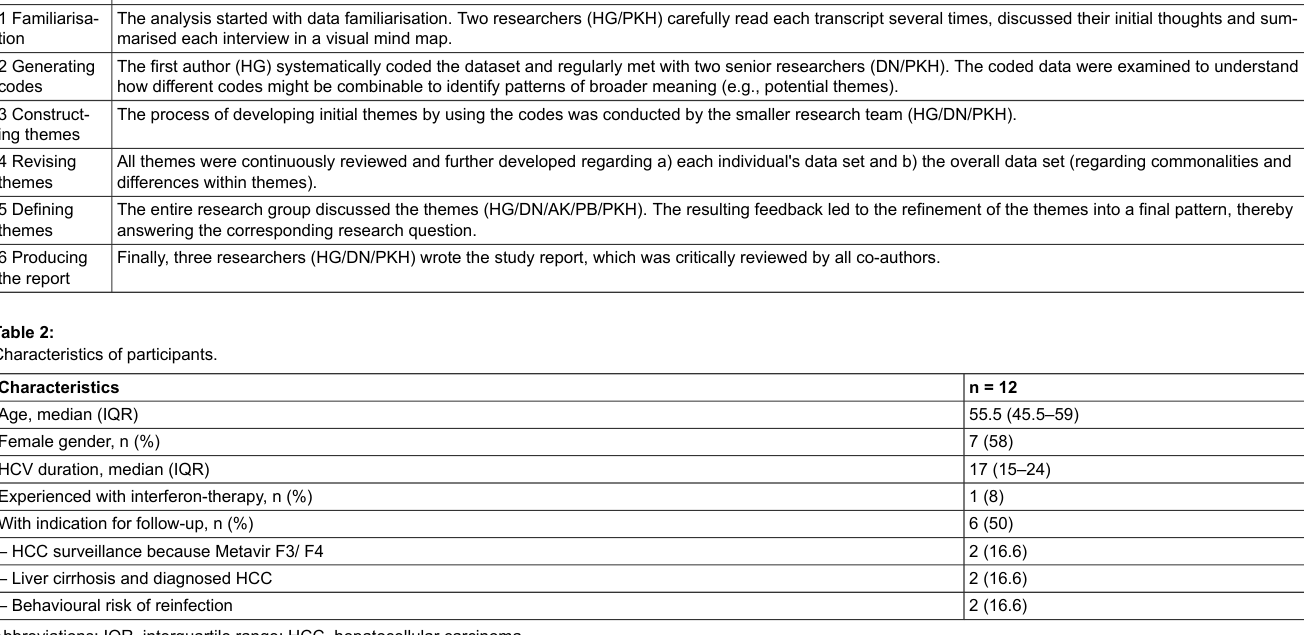
Table 1: Phases of reflexive thematic analysis. Phase Description of the process